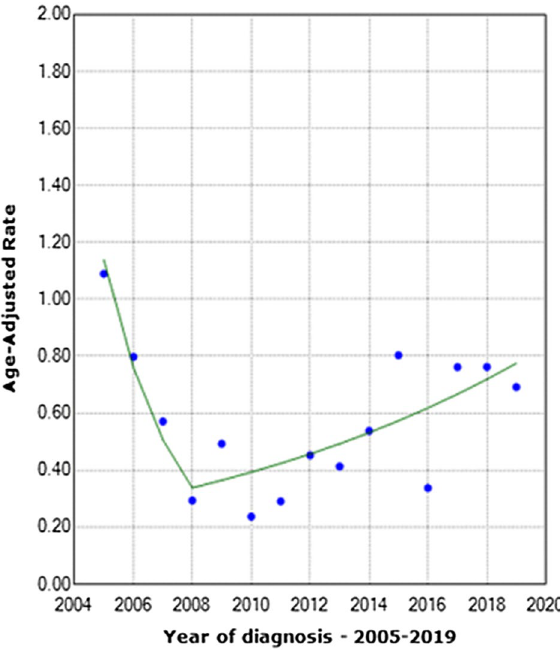
Figure 4. Joinpoint models showing the changes in average annual incidence rates from 2005 to 2019.